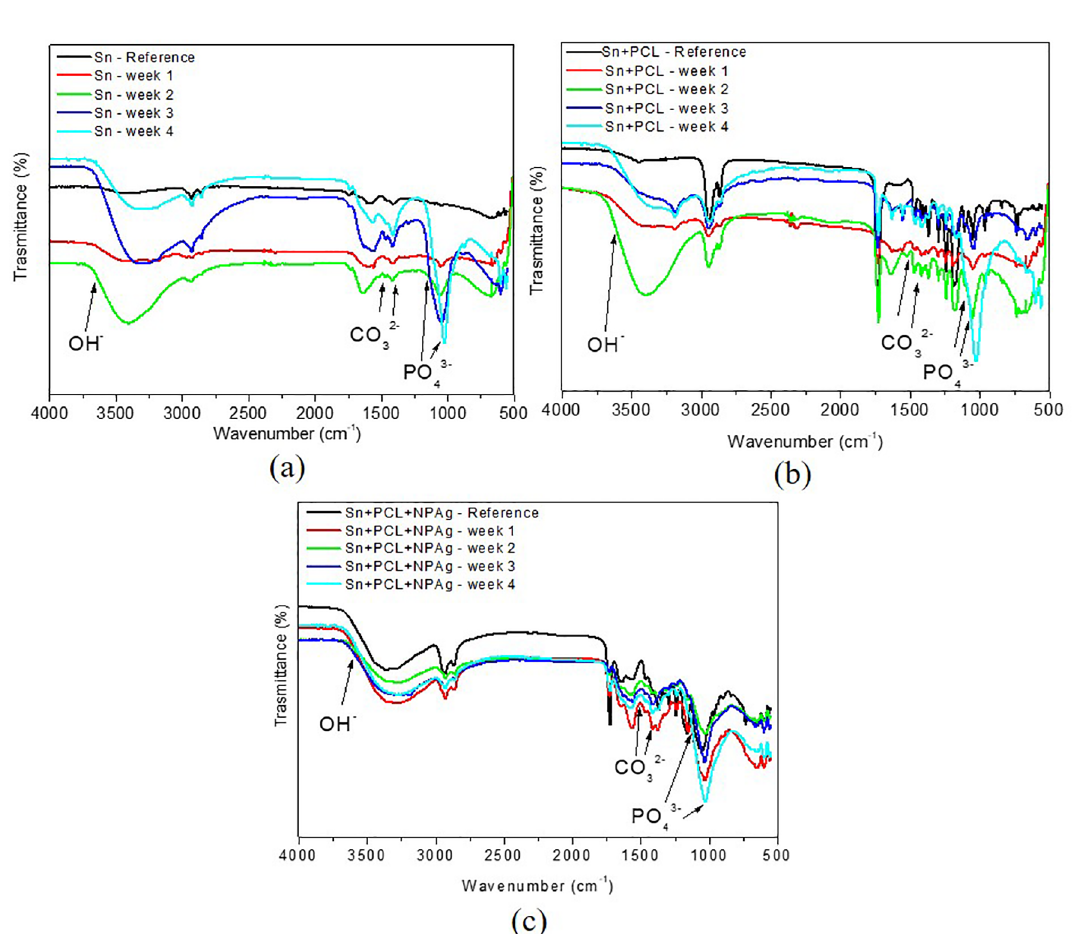
Figure 6. FTIR analysis after bioactivity assay. (a) Sn-ribbon, (b) Sn+PCL-ribbons and (c) Sn+PCL+NPAg-